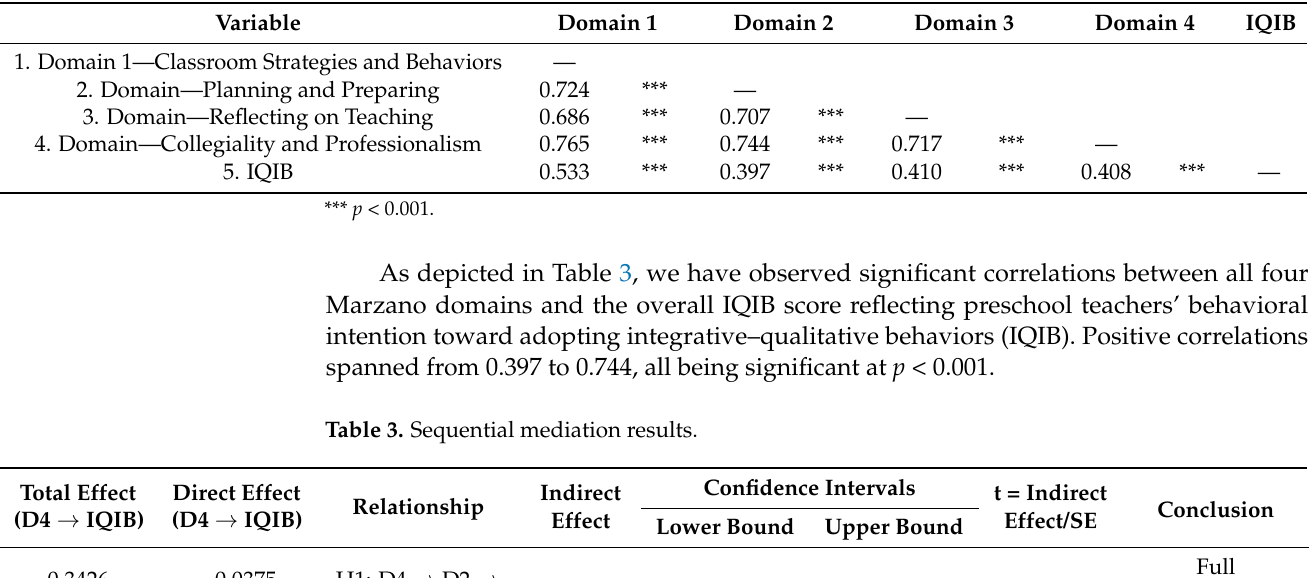
Table 2. Pearson’s Correlations.